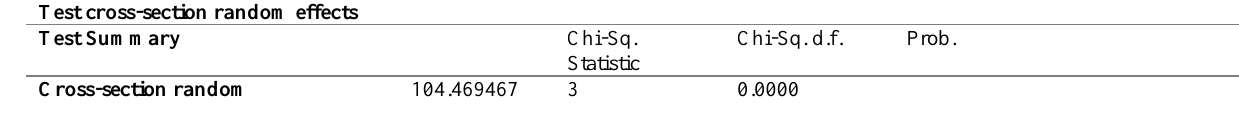
Table 2: Correlated Random Effect – Hausman